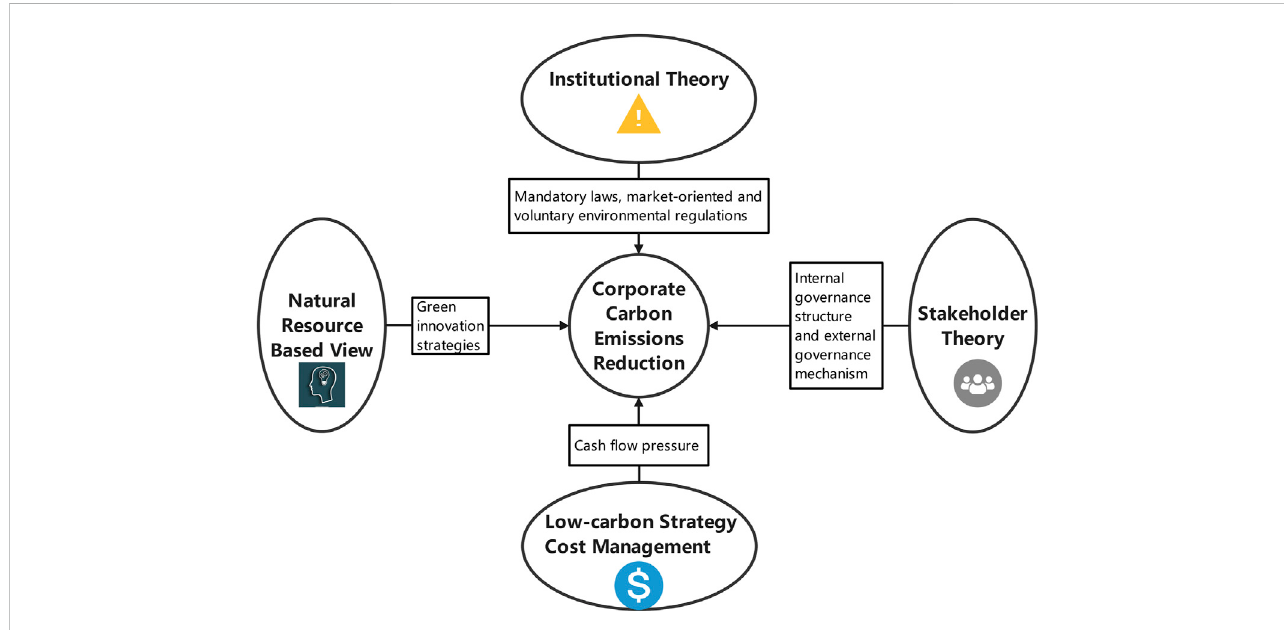
FIGURE 3 Corporate carbon emissions reduction